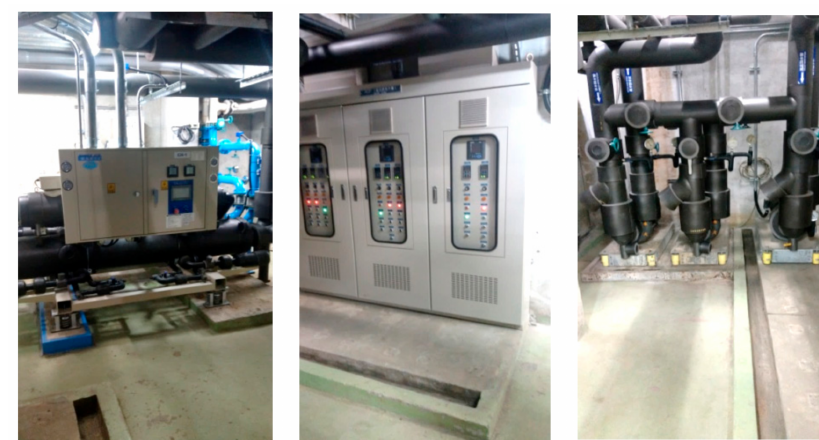
Figure 4. Replacement of RB air-conditioner and related equipment.